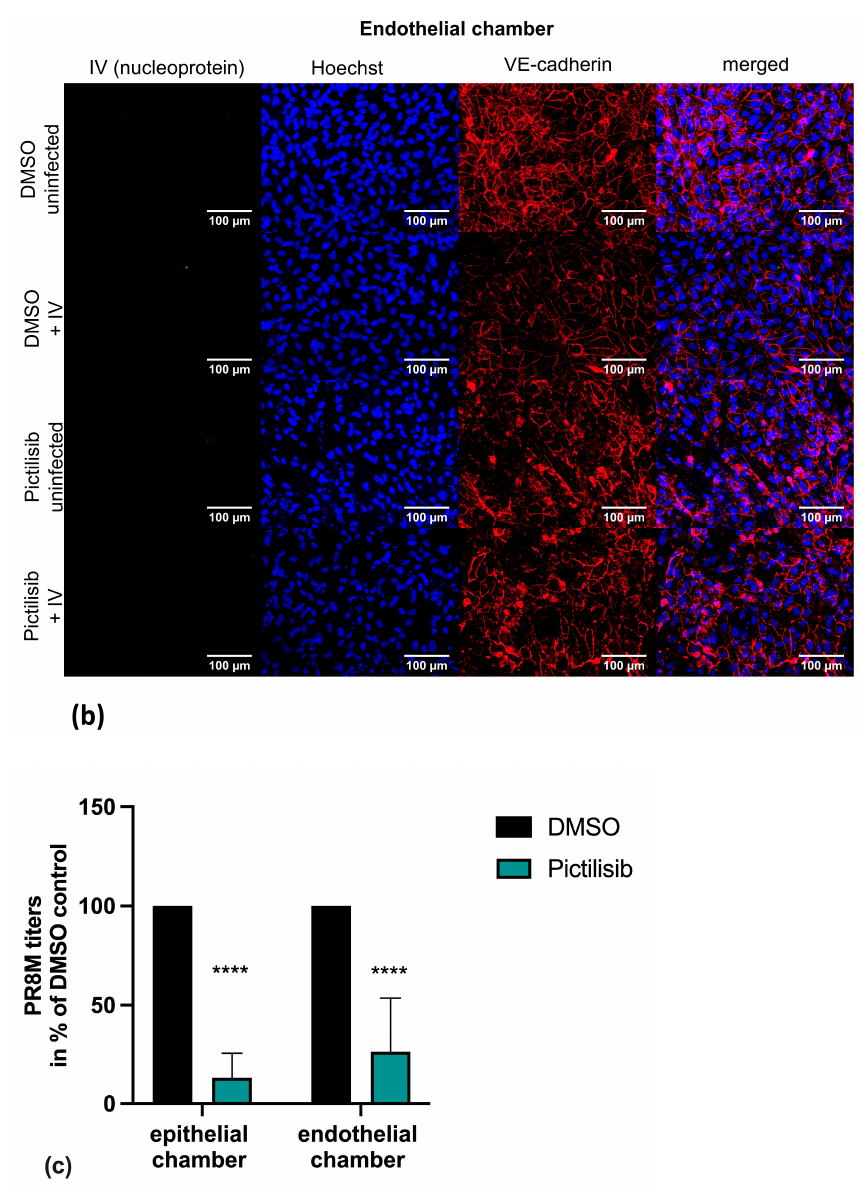
Figure 5. Pictilisib inhibits viral replication in the human chip model. The epithelial and endothelial sites of the human chip model were pre-incubated with 10 µ M Pictilisib or solvent control (DMSO) for 30 min prior to infection. PR8M infection (MOI 0.1) was then performed for 30 min on the epithelial site of the model. The chip was incubated with Pictilisib (10 µ M) or DMSO to 24 h p.i. ( a , b ) The cell layers of the epithelial ( a ) and endothelial chamber ( b ) were stained using primary antibodies against IV nucleoprotein (a,b), E-cadherin ( a ) and VE-cadherin ( b ), Nuclei were stained with Hoechst ( a , b ). ( c ) Viral titers were determined by standard plaque assay. The solvent control was arbitrarily set to 100%. Data represents the mean + SD of eight independent experiments. Statistical significance was determined by multiple t -tests (**** p <